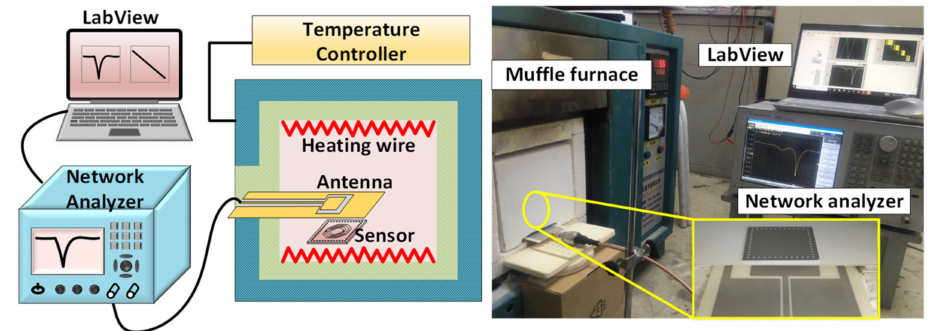
Figure 9. Schematic of the high-temperature testing